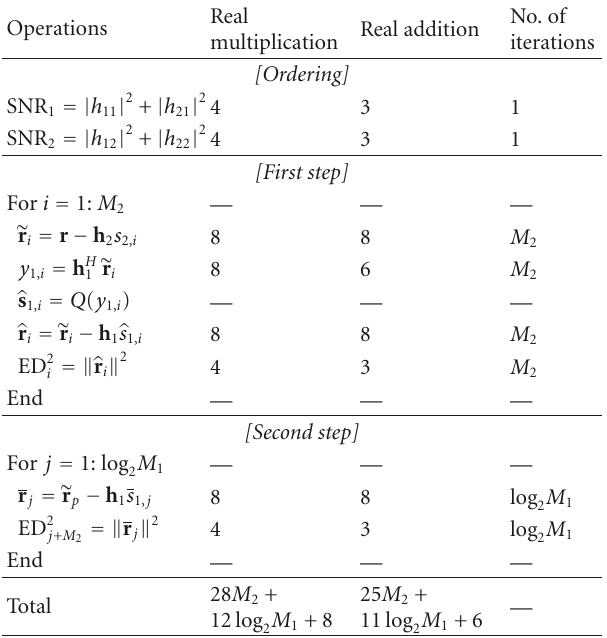
Table 2: Complexity analysis for the proposed scheme I ( N t = N r = 2, per one subcarrier).